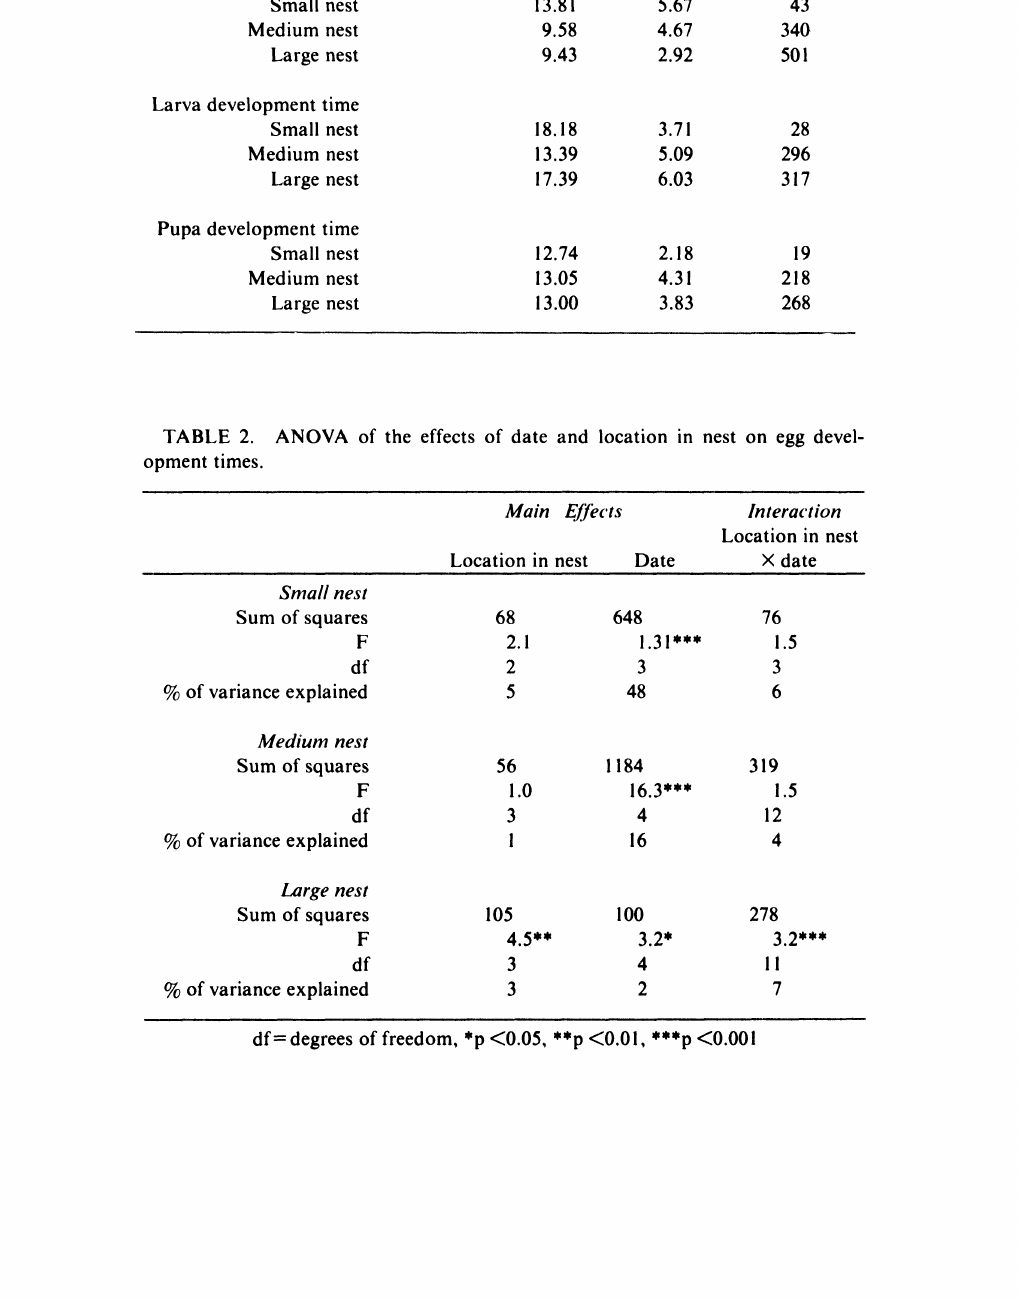
TABLE I. Average brood development times per nest.